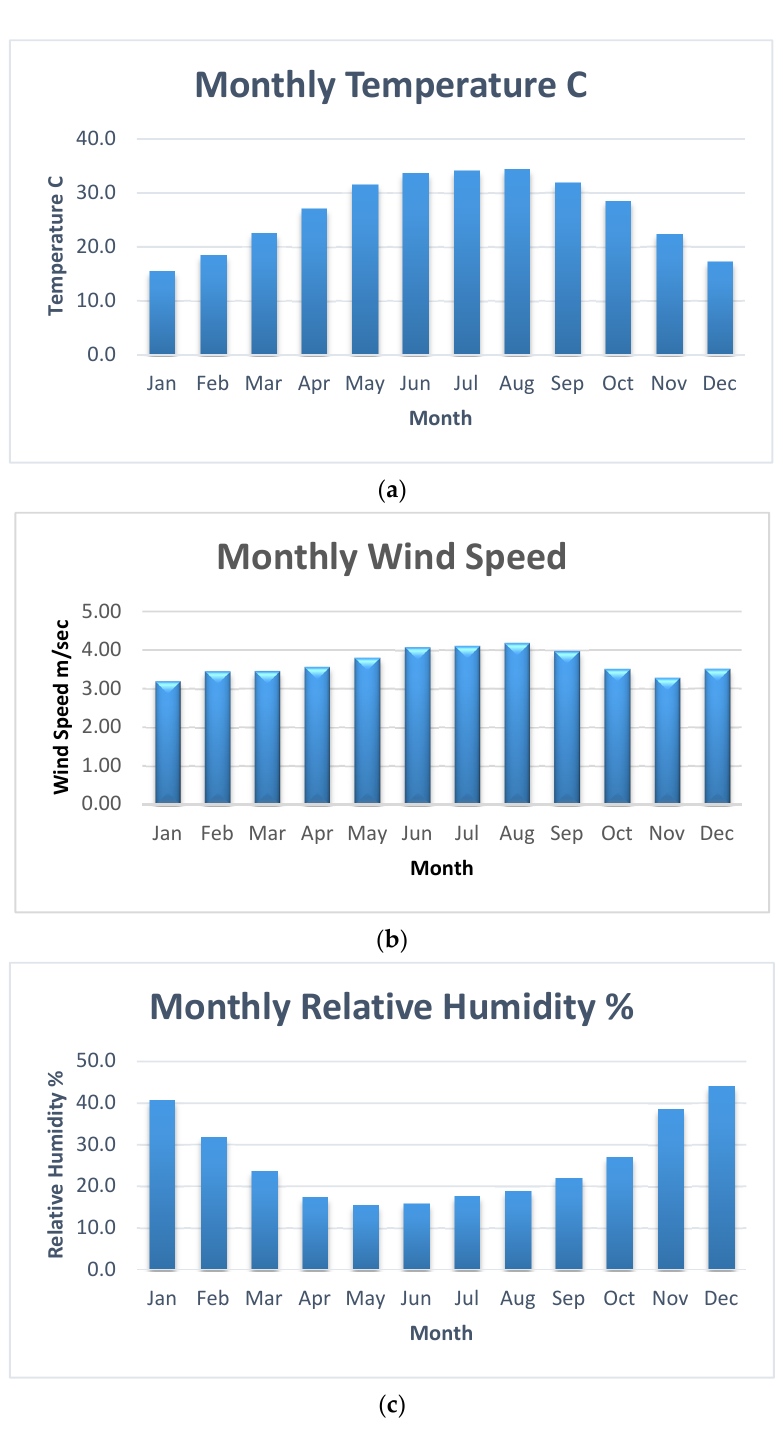
Figure 3. Meteorological data of Lake Nasser from 2009 to 2020: ( a ) average monthly temperature (°C), ( b ) average monthly wind speed (m/sec), ( c ) average monthly relative humidity (%).